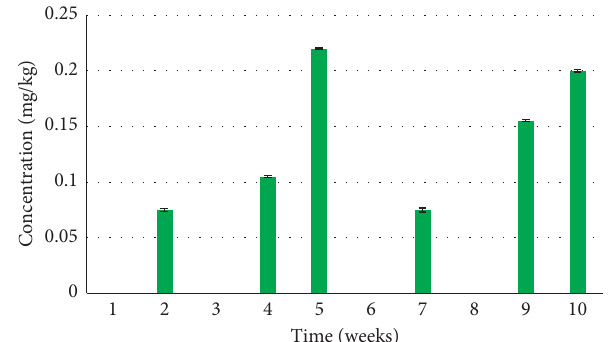
Figure 3: Concentration of α -endosulfan pesticide residue in